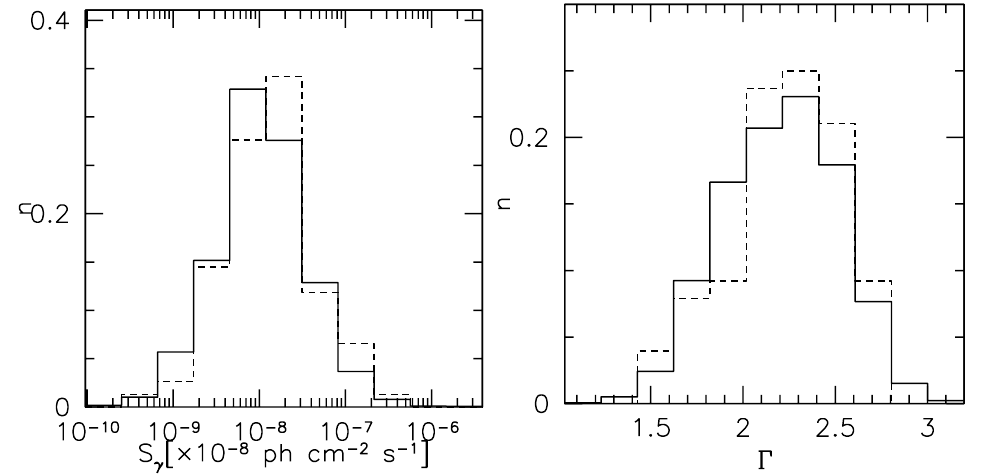
Figure 4. Gamma-ray photon flux and index distribution for the entire 3LAC (solid histogram) and the subset observed with ALMA (dashed histogram).